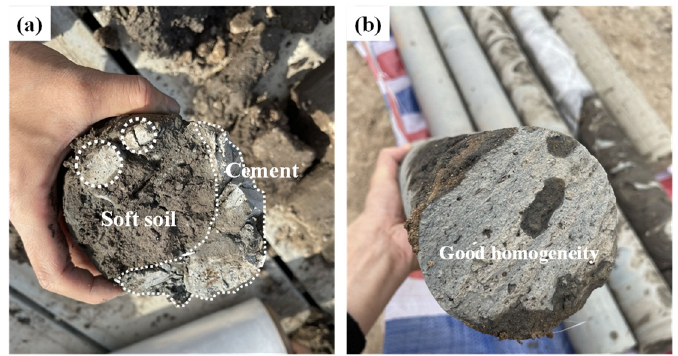
Figure 5. Homogeneity of different types of solidifying materials in a deep mixing pile: ( a ) cement and ( b ) solidifying agent.